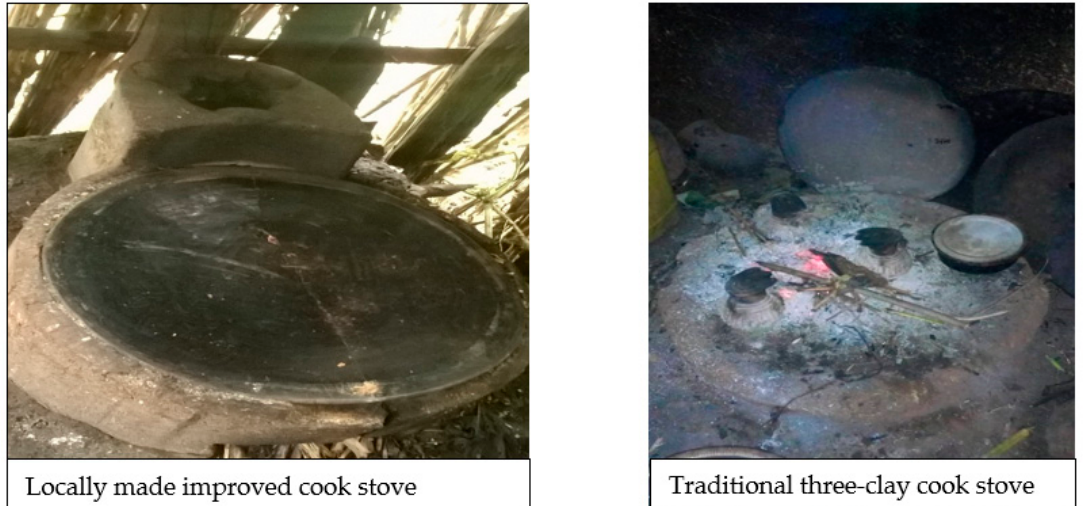
Figure 1. Photos of locally made improved cook stove and traditional three-clay cook stove.